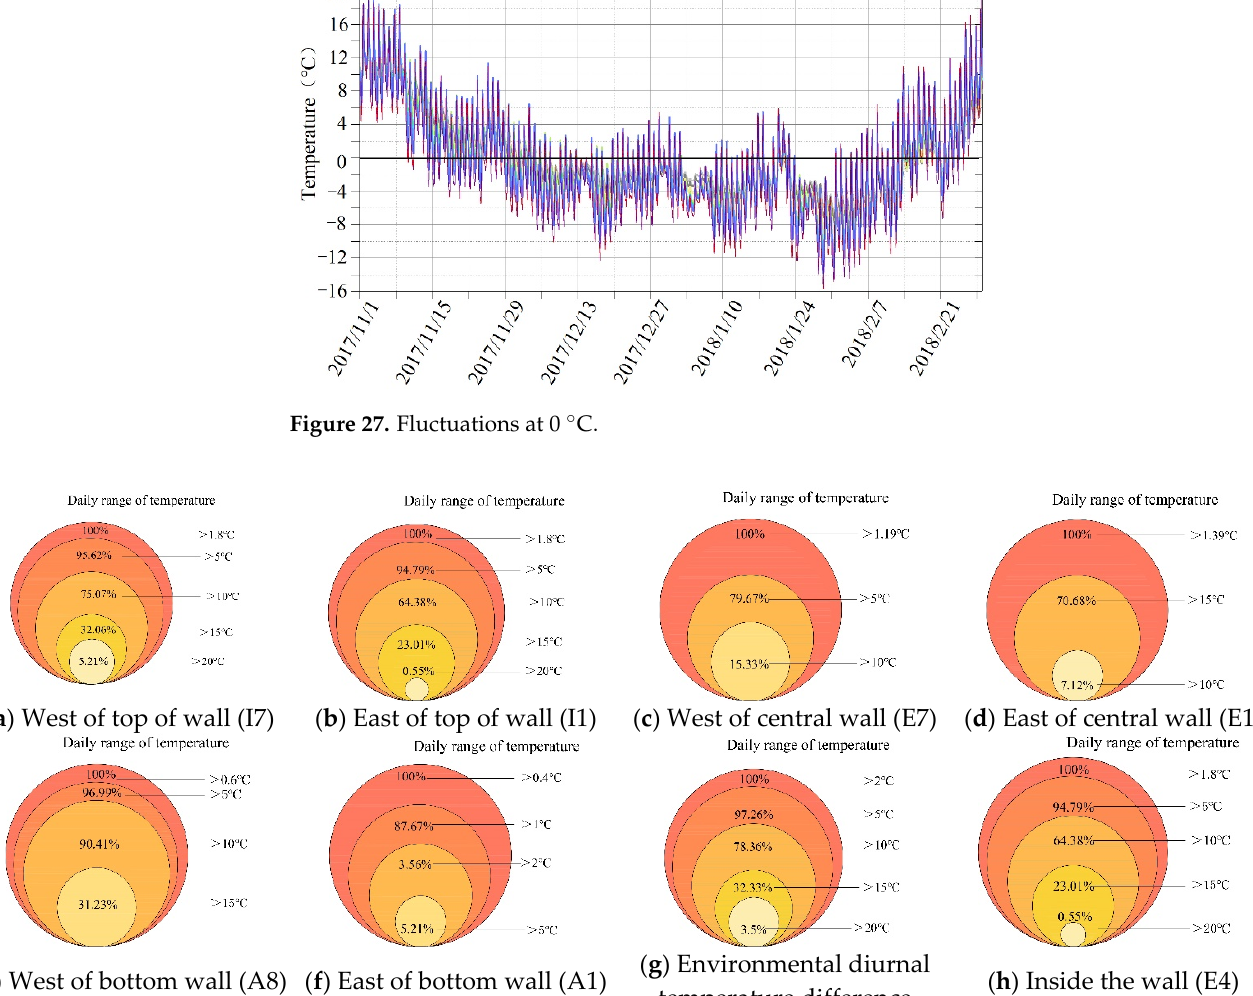
Figure 28. Statistical analysis of the daily temperature difference between the atmosphere and the wall.